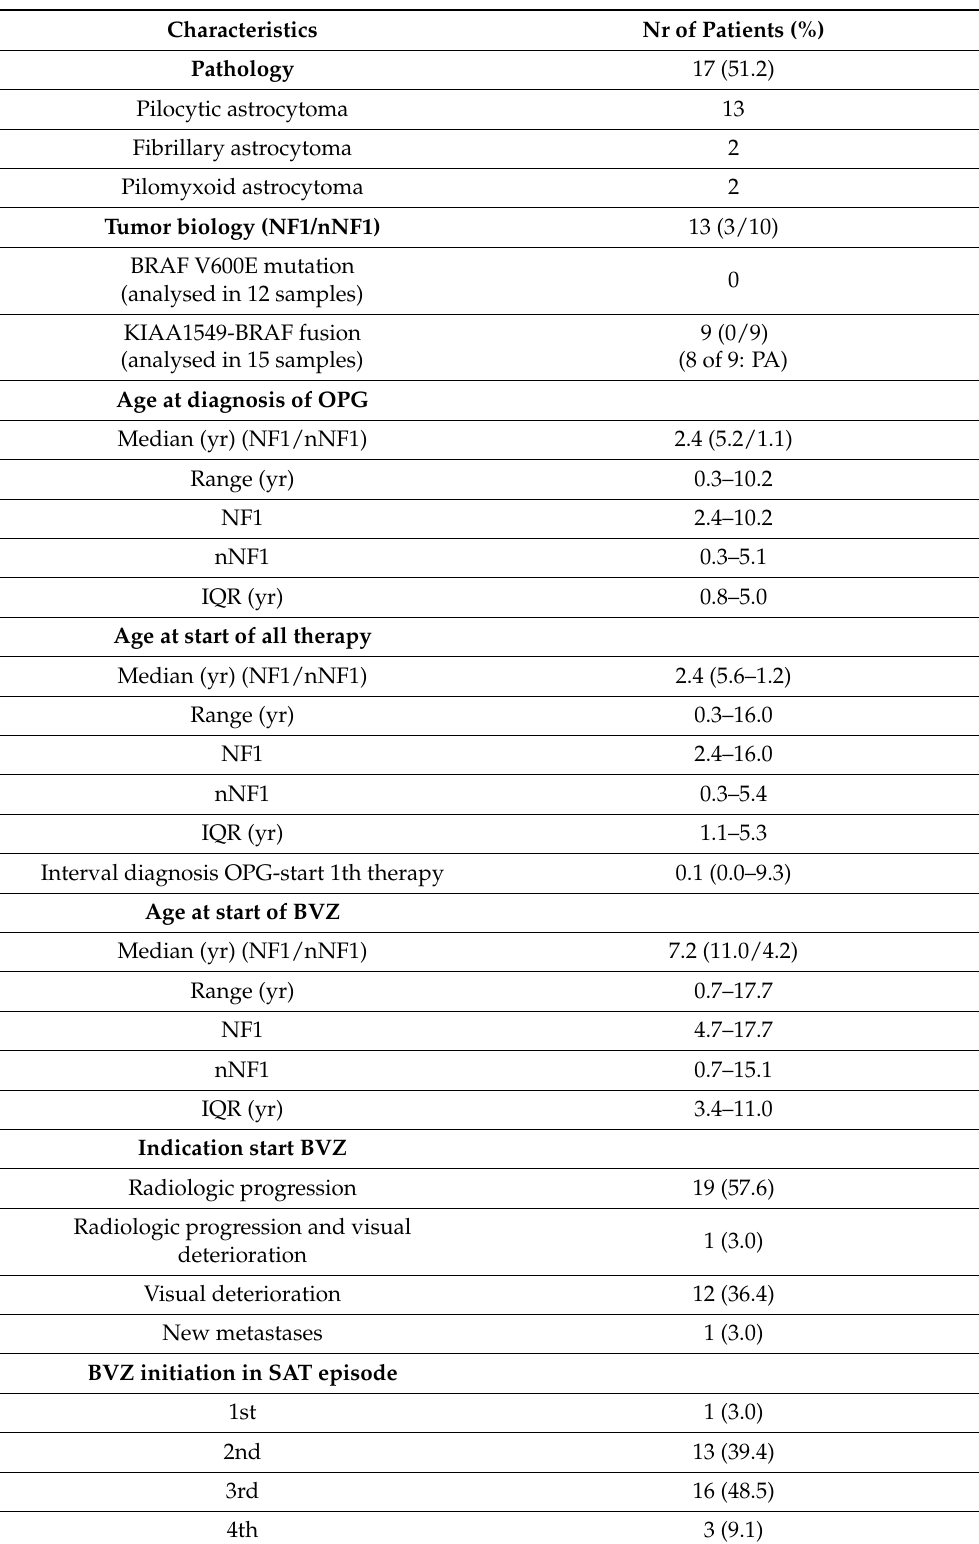
Table 1. Baseline characteristics of pediatric patients with OPG at start of treatment with